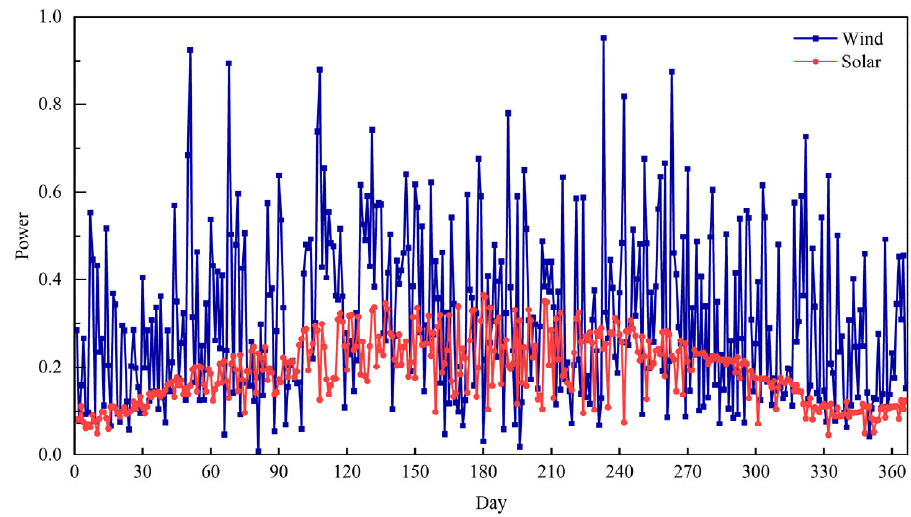
Figure 1. Wind and solar output in Region 3.